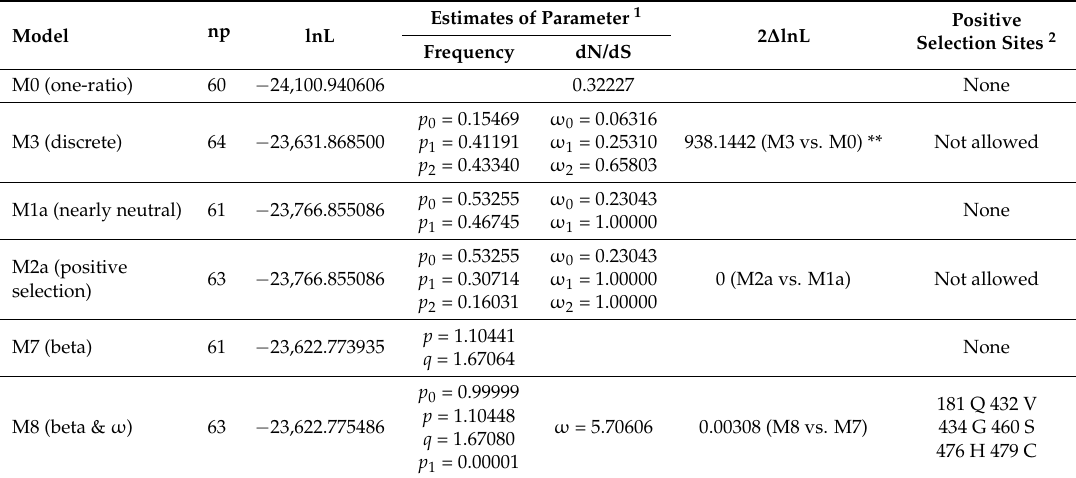
Table 1. Tests for positive selection among codons of SmSABATH genes using site